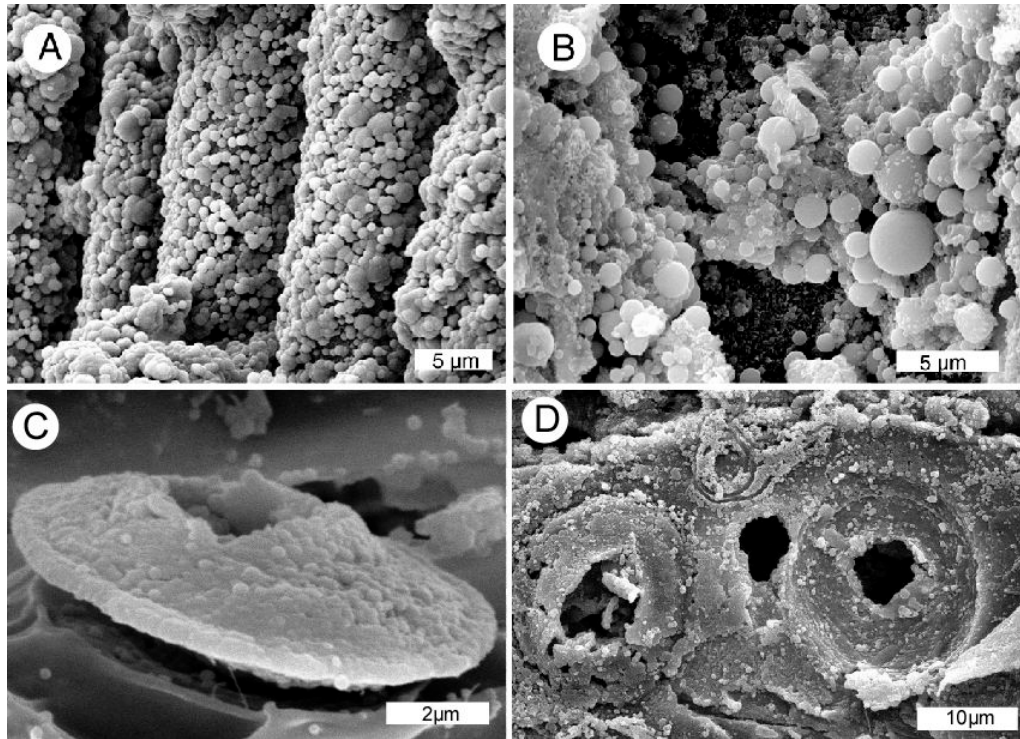
Figure 16. Neogene fossil wood showing opal-A microspheres. ( A ) Miocene, Virgin Valley northern Nevada, USA. ( B ) Pliocene, Hazen, central Nevada USA. ( C, D ) Bordered pits in Pinus contorta , showing coalescence of opal-A microspheres, from modern hot springs at Yellowstone National Park, Wyoming, USA.